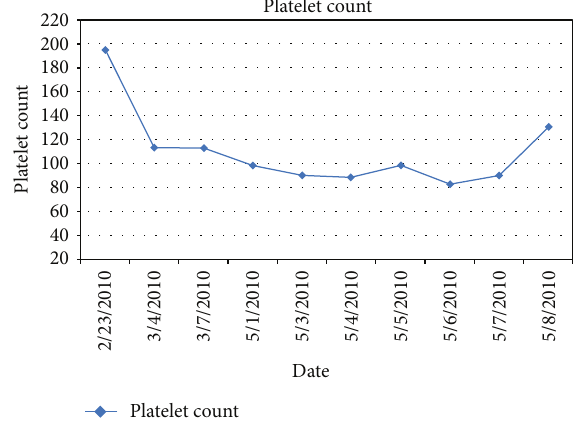
Figure 1: Platelet count values over time.